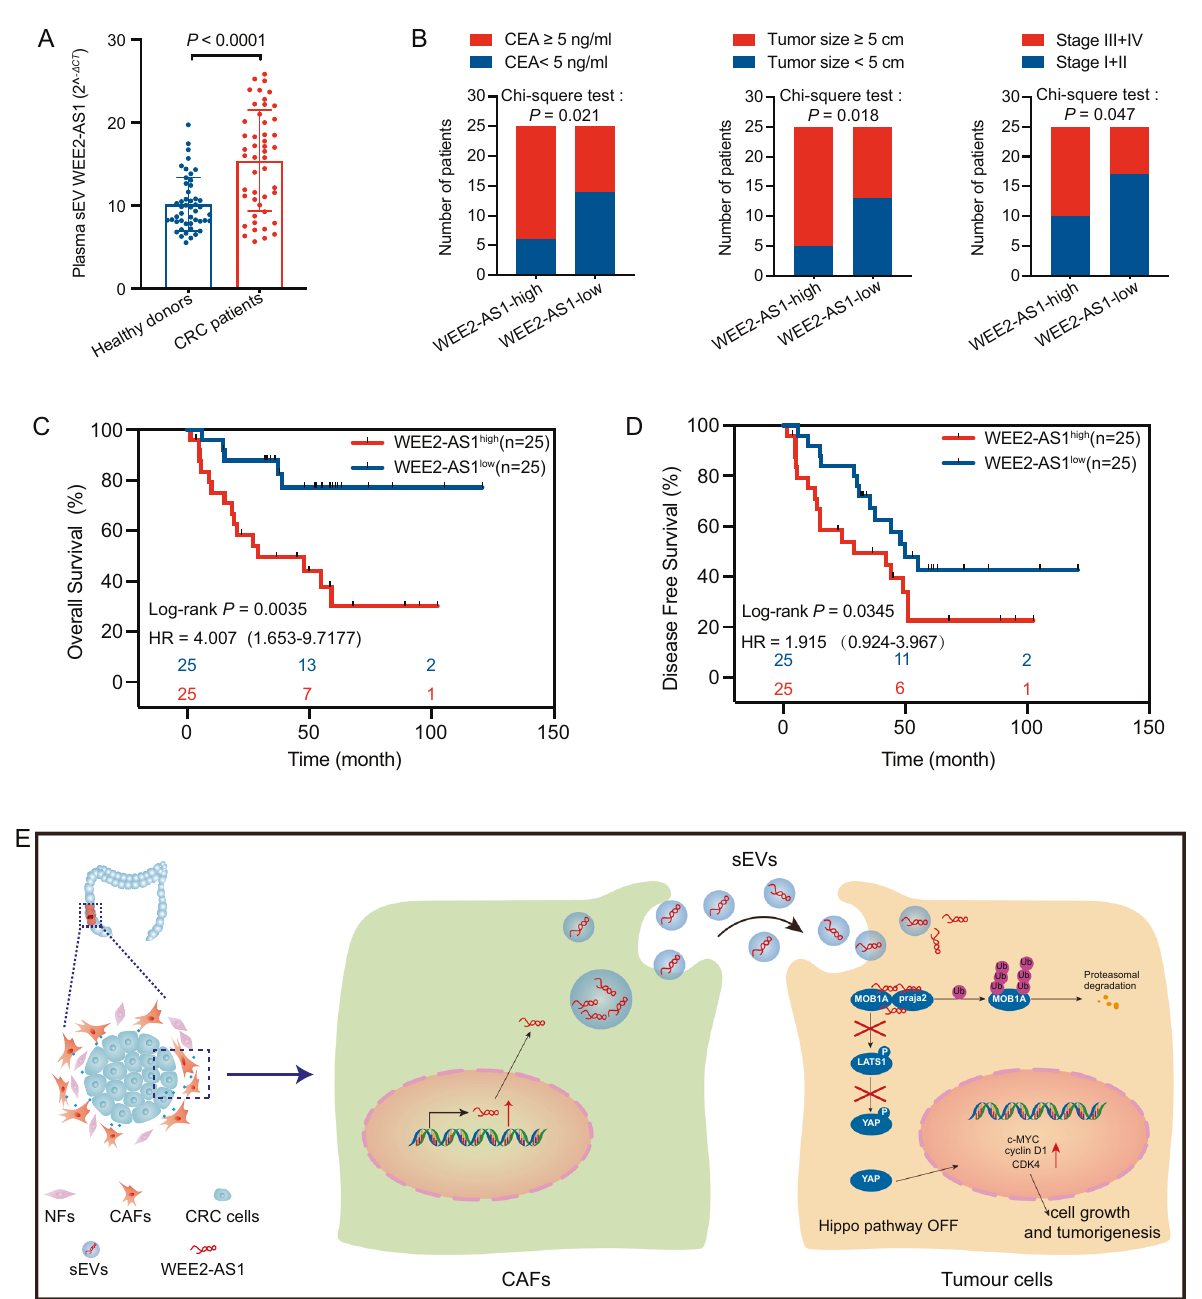
Fig. 8 Upregulated plasma sEVs WEE2-AS1 correlates with poor prognosis of CRC patients. A Expression of plasma sEVs WEE2-AS1 in healthy donors ( n = 50) and CRC patients ( n = 50). B High plasma sEVs WEE2-AS expression was correlated with increased CEA level, tumor size, and TNM stage in 50 CRC patients. C , D . Kaplan – Meier overall survival and disease-free survival curves according to WEE2-AS1 expression levels. E Concise model of CAF-sEVs WEE2-AS1 in regulating CRC progression. WEE2-AS1 in CAFs could be secreted into TME via sEVs. samples, we identi fi ed an oncogenic lncRNA, WEE2-AS1, which Unsurprisingly, we found that CAF-sEVs WEE2-AS1 promoted CRC was upregulated in CAF-sEVs compared with NF-sEVs. cell proliferation, and inhibited cell apoptosis in vitro. Further- WEE2-AS1 has been frequently considered as a classical more, the subcutaneous xenograft model also showed that CAF- oncogene and is involved in proliferation, apoptosis, and sEVs WEE2-AS1 promoted CRC cell growth in vivo. Importantly, we metastasis in various cancer. For example, WEE2-AS1 promotes breast cancer cells proliferation and inhibits apoptosis [29]. In established AOM/DSS-induced cancer (CAC) models and found hepatocellular carcinoma, WEE2-AS1 accelerates the proliferation, that CAF-sEVs WEE2-AS1 promoted more and larger colorectal tumor migration of HCC cells [30]. In addition, WEE2-AS1 not only has a formation in AOM/DSS-induced CRC. Together, our results indicate pro-oncogenic effect on tumor cells but also regulates human that WEE2-AS1 can act as an oncogenic lncRNA in CRC. vascular endothelial cell viability [31]. However, so far, the role of The hippo signaling pathway has crucial roles in the control of WEE2-AS1 in CRC has not been elucidated. Our study revealed that organ size, carcinogenesis, tissue regeneration, and dysregulation